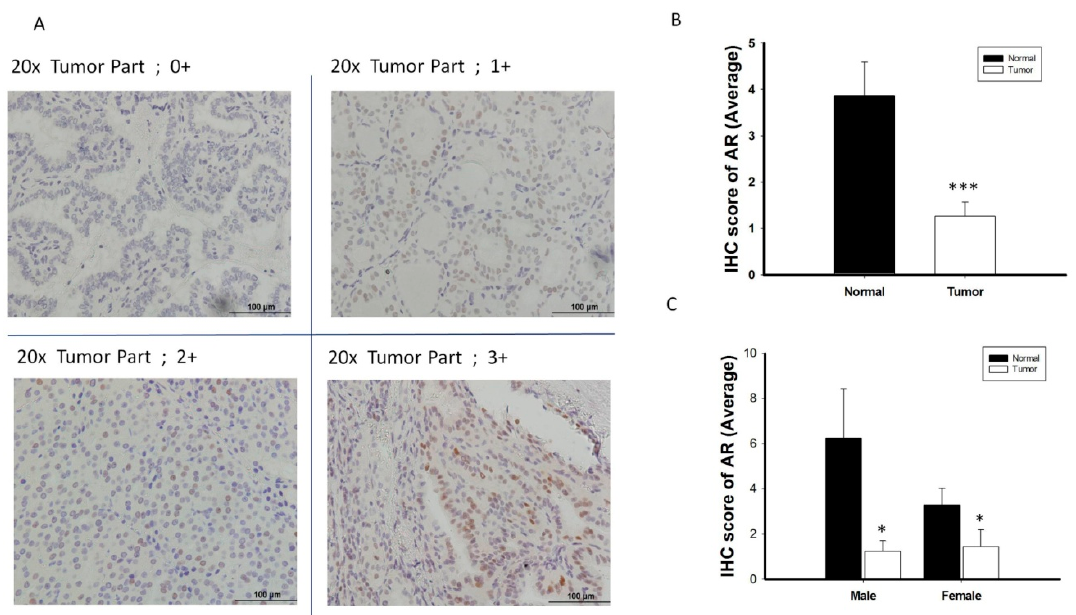
Figure 3. The analysis of androgen receptor (AR) protein expression level by immunohistochemistry (IHC) ( n = 38). ( A ) Scoring classification of IHC; 0, negative ( − ); 1+, weakly positive; 2+, moderately positive (++); 3+, strongly positive (+++). ( B ) Normal thyroid tissue express high expression level of AR protein scoring than its paired cancerous specimen. ( C ) The expression of AR protein is significantly decreased in PTC tumor specimens than its adjacent normal tissue in both male and female gender patient. * p < 0.05 *** p < 0.001